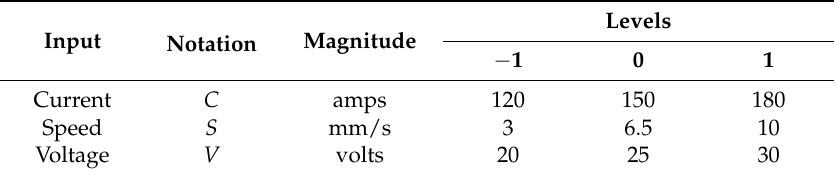
Table 1. Independent variables and experimental design levels used with the Box–Behnken design (BBD) method.